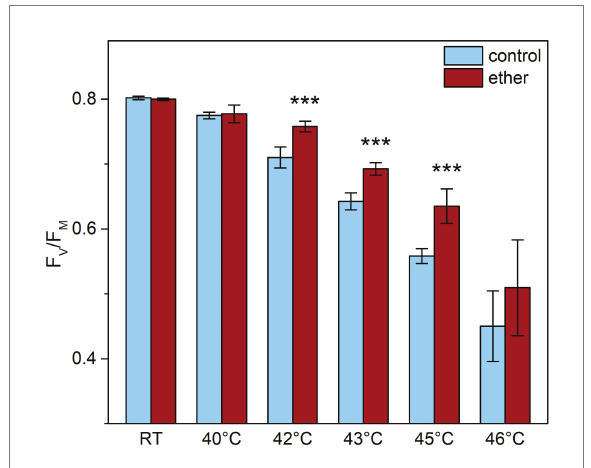
FIGURE 9 Maximal quantum yield of PSII photochemistry (F V /F M ) in leaves of control and diethyl ether pre-treated Arabidopsis thaliana plants. Detached leaves were incubated for 5 min in a water bath of given temperature in darkness. RT, room temperature. Means ± SD, n = 5. Asterisks (***) indicate statistically significant difference from untreated samples ( p < 0.001; Student’s or Welch’s t